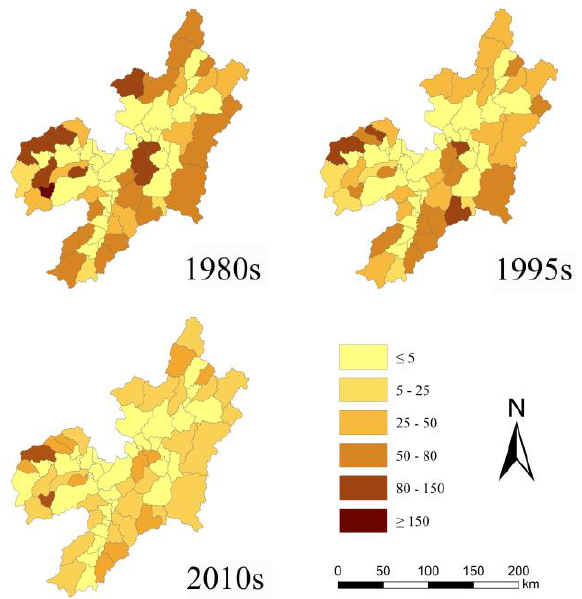
Figure 3. Soil erosion distribution of each sub-basin for the years 1980s, 1995s, and 2010s (t/ha/yr).